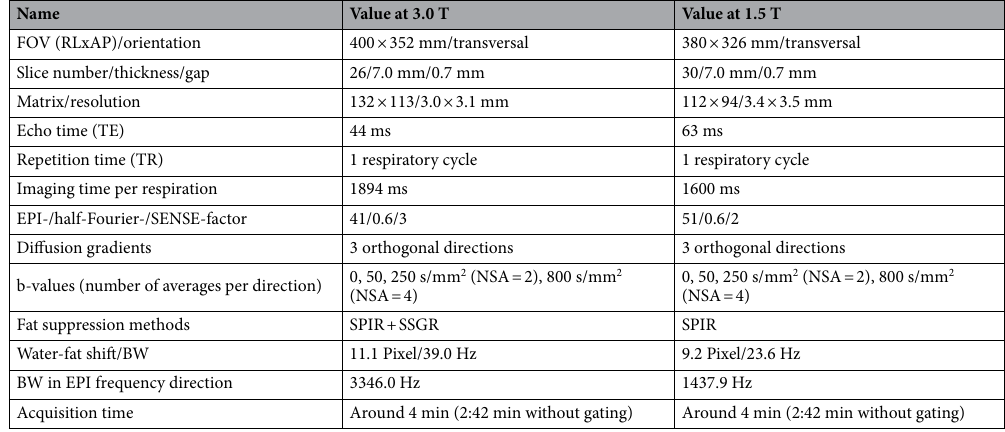
Table 2. Parameters of the diffusion-weighted imaging (DWI) sequence. SENSE—parallel imaging with sensitivity encoding, FOV—field of view, RL—right-left, AP—anterior–posterior, EPI—echo-planar imaging, SPIR—spectral presaturation by inversion recovery, SSGR—slice-selective gradient reversal (uses slice- selection gradients of opposite polarity for the 180° pulses taking advantage of the chemical shift of fat with respect to water),